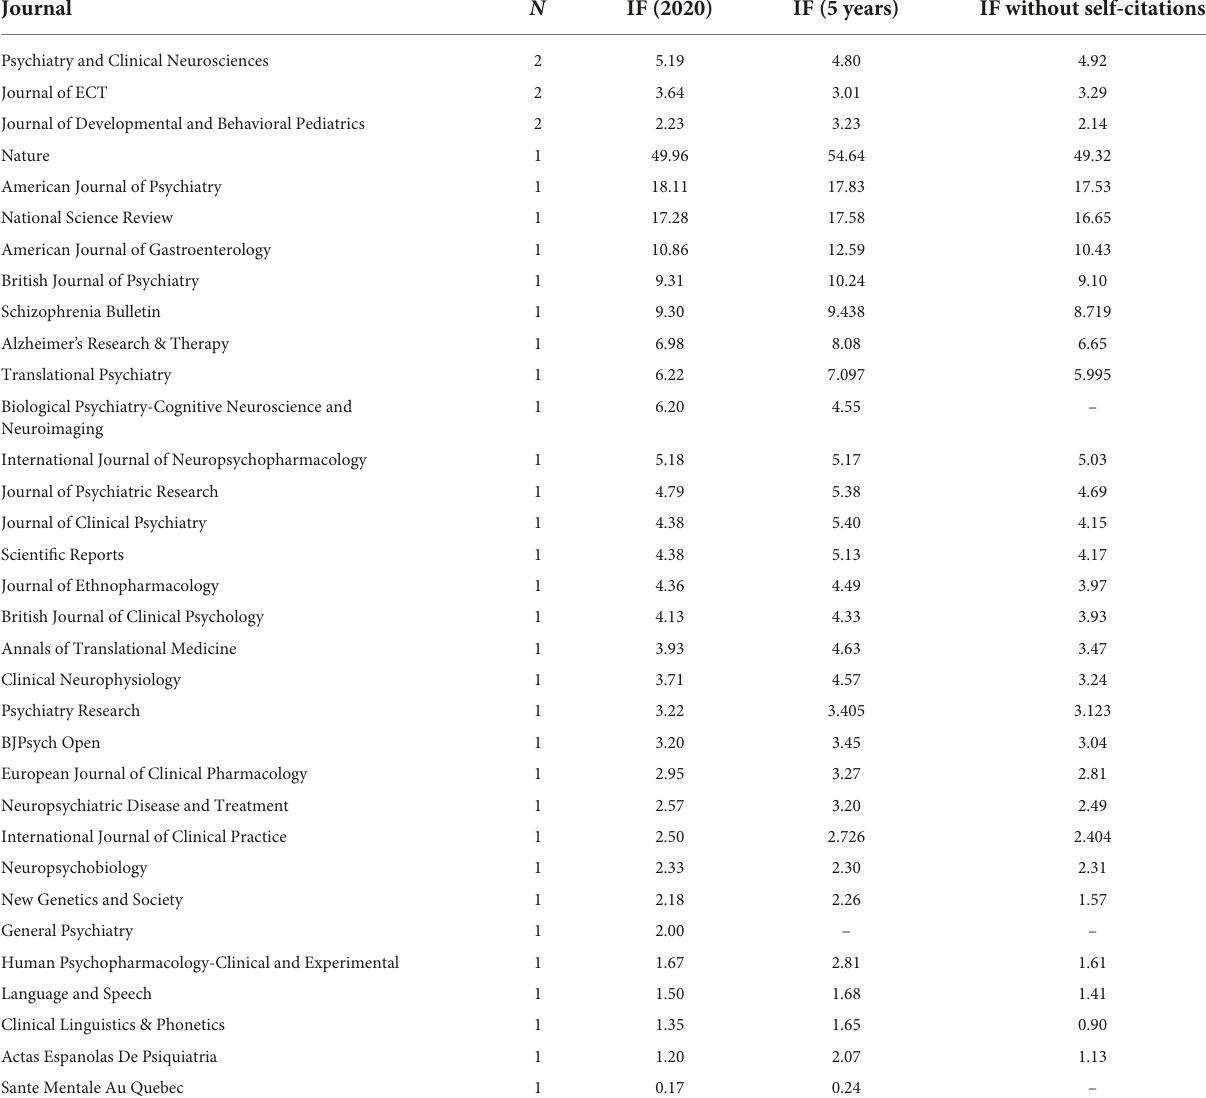
TABLE 2 Journals with retracted publications on schizophrenia-related